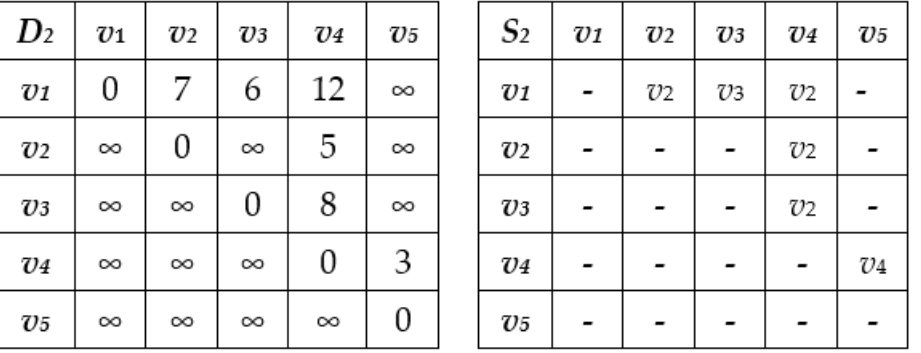
Figure 6. Matrices D 2 and S 2 , s iteration.